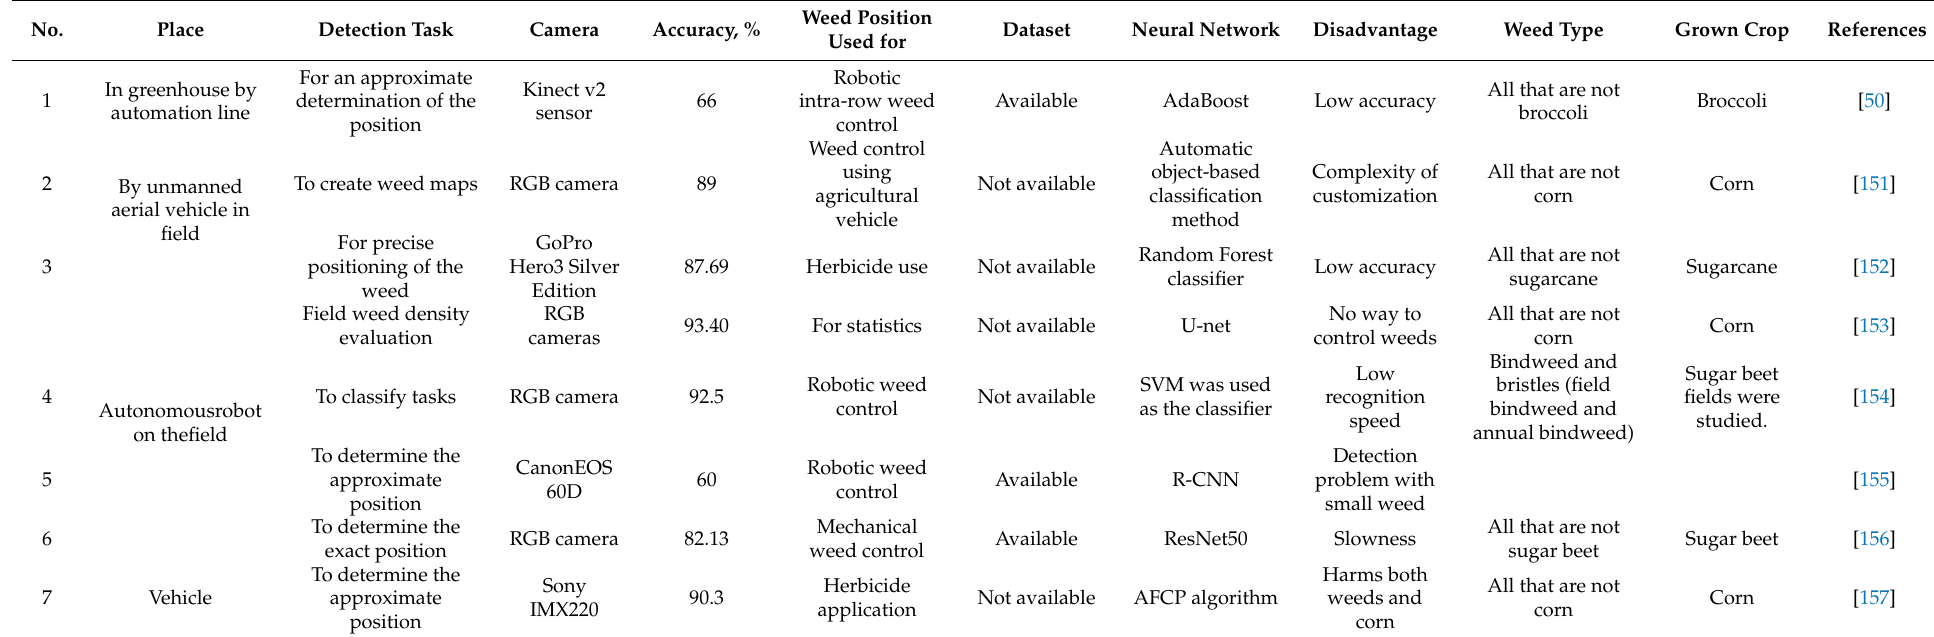
Table A1. Applying deep learning to agriculture for weed